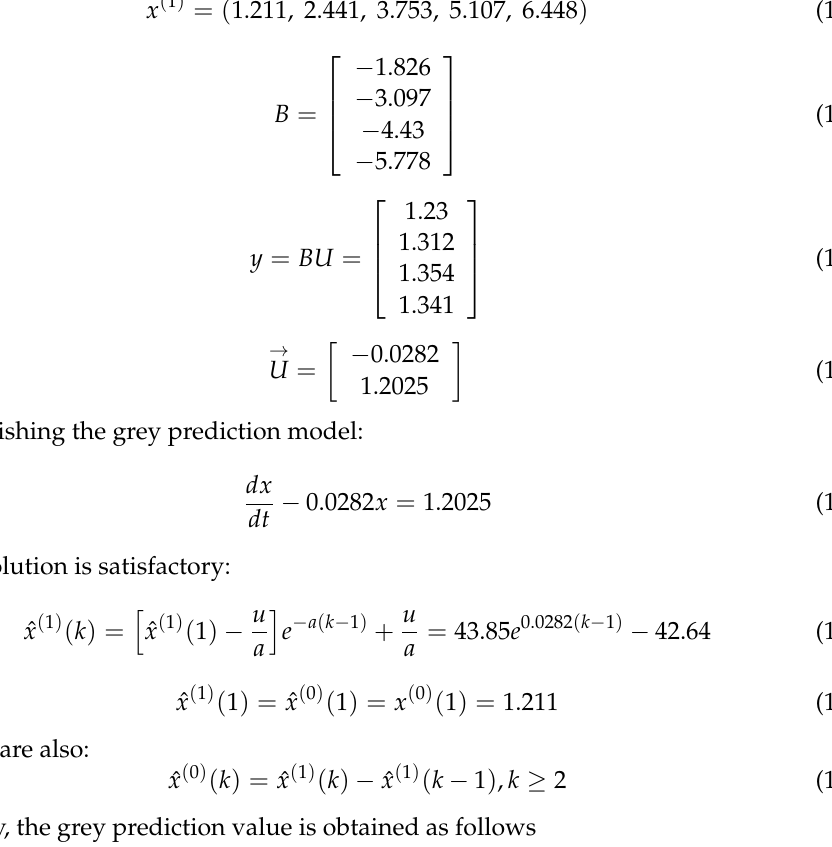
Figure 3. Analysis of measured value of gas emission in intake and return air roadway of working face.